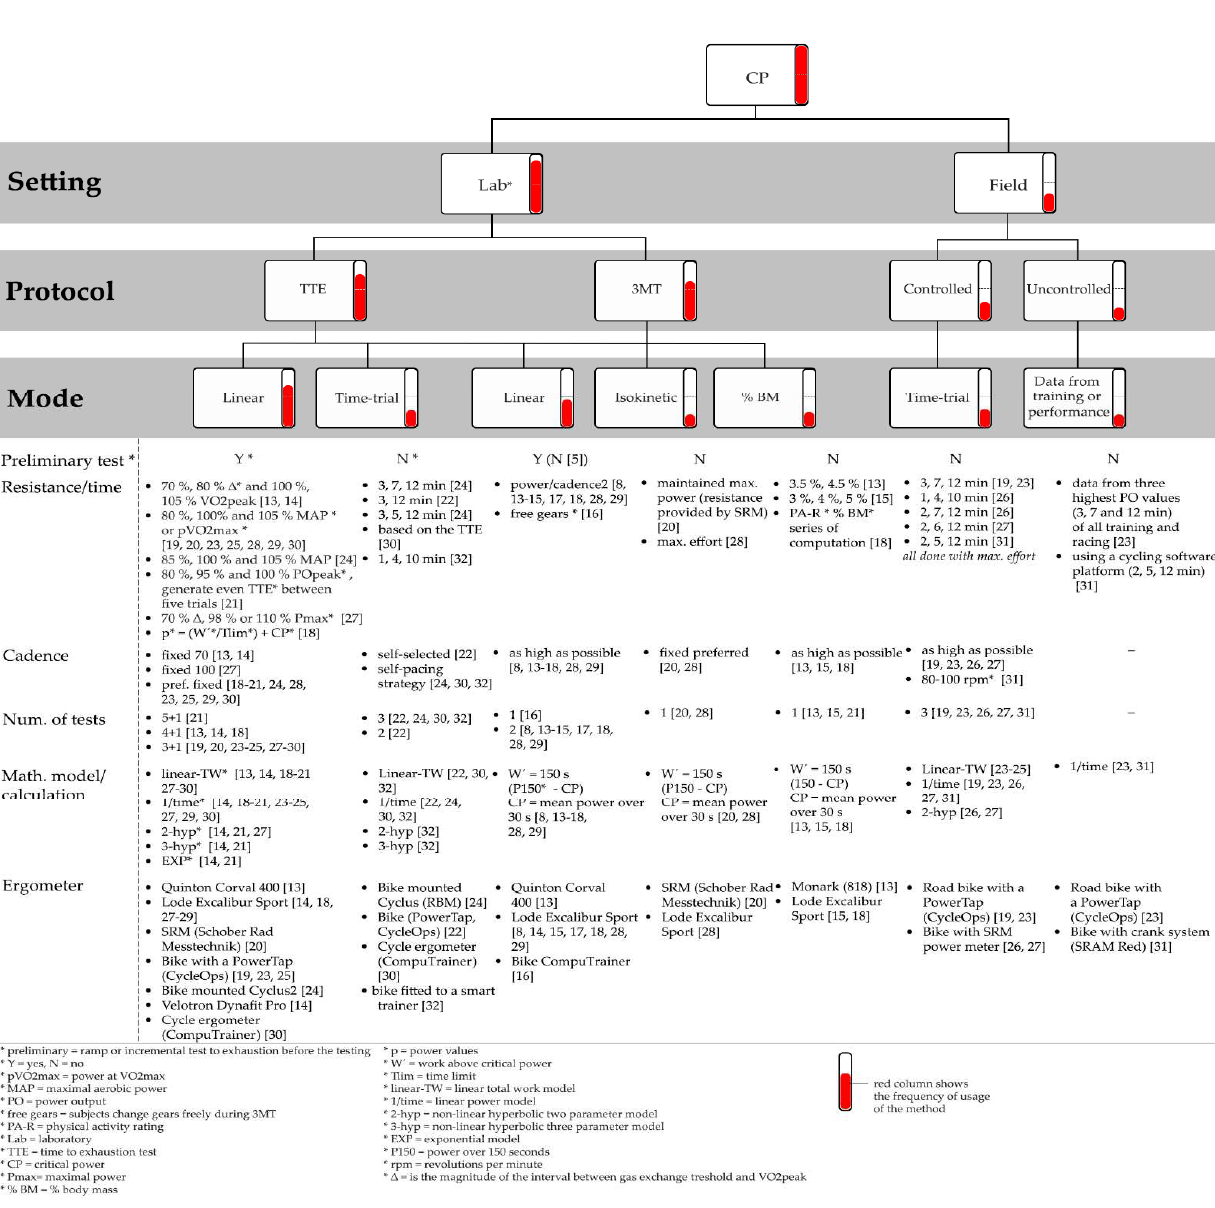
Figure 3. Scheme of all methods from studies included in this review [8,13–32]. ( * explanation of the